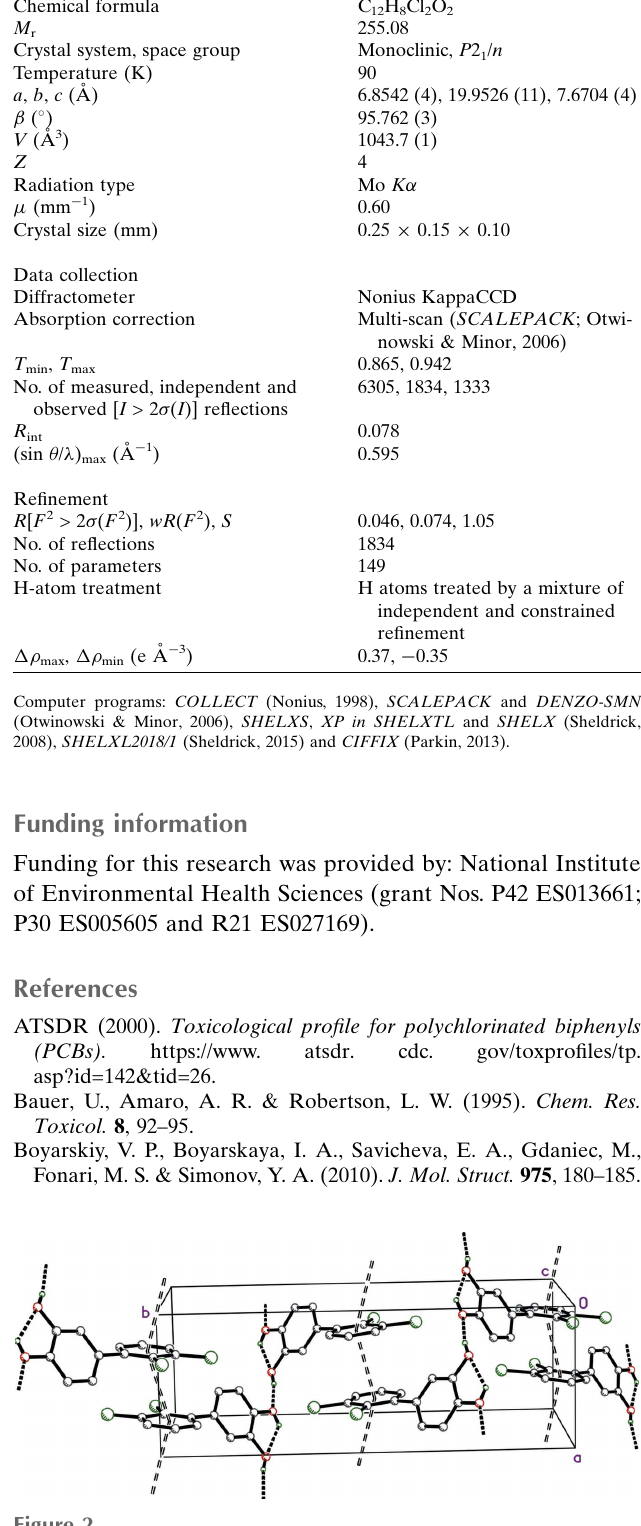
Table 2 Experimental details. Crystal data Chemical formula